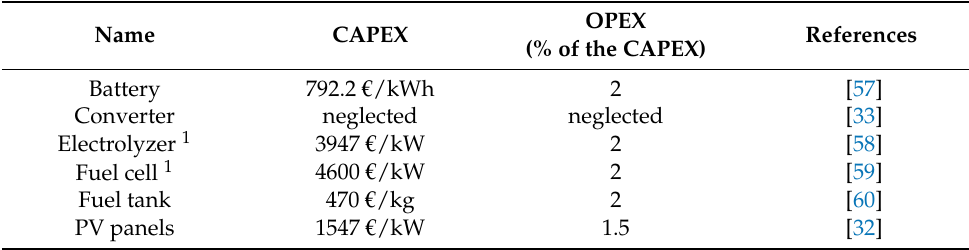
Table 1. Economic settings of the